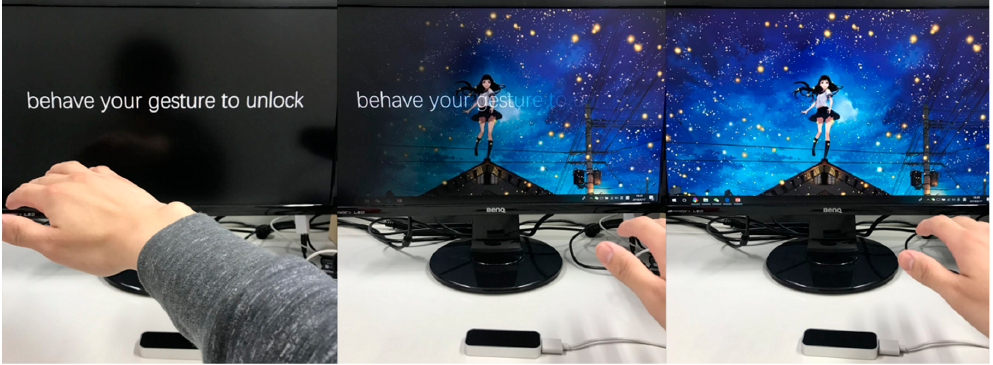
Figure 2. Unlock computer by gesture.